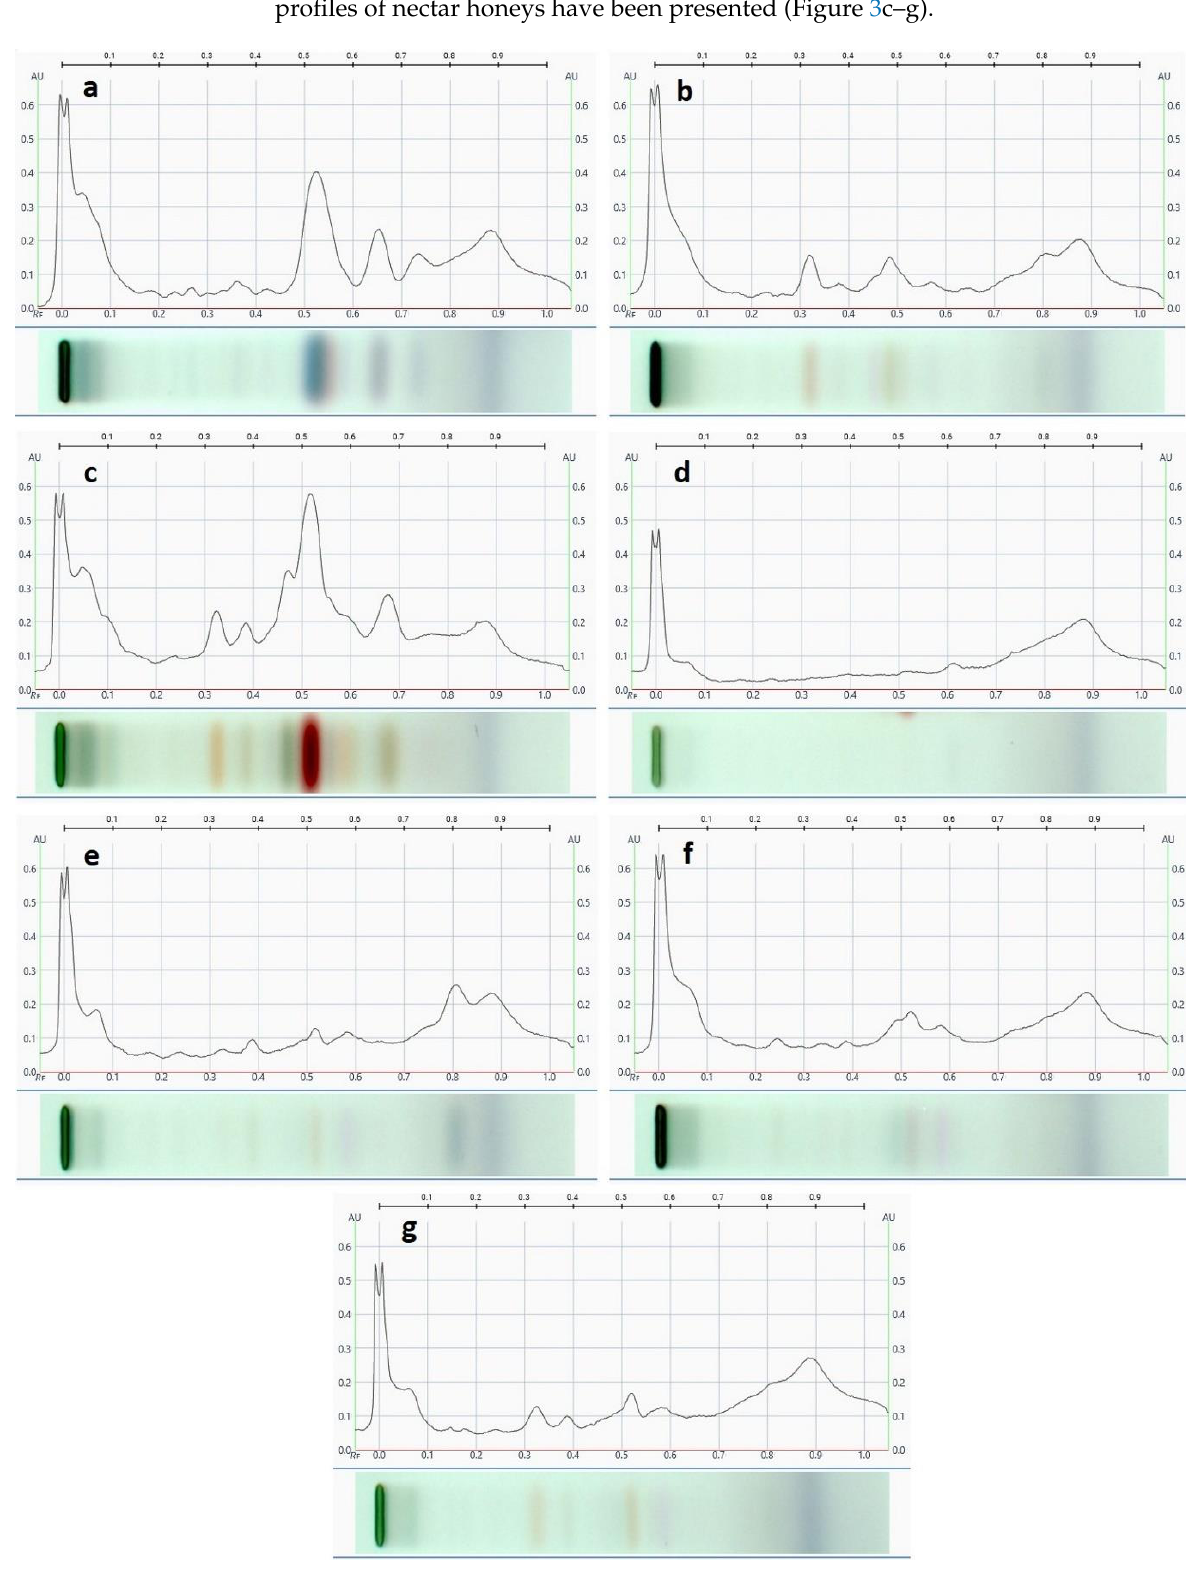
Figure 3. HPTLC polyphenolic profile to distinguish fir honeydew honey tested samples ( a,b ) and other nectar honeys: heather ( c ), acacia ( d ), multifloral ( e ), buckwheat ( f ), and rape ( g ).